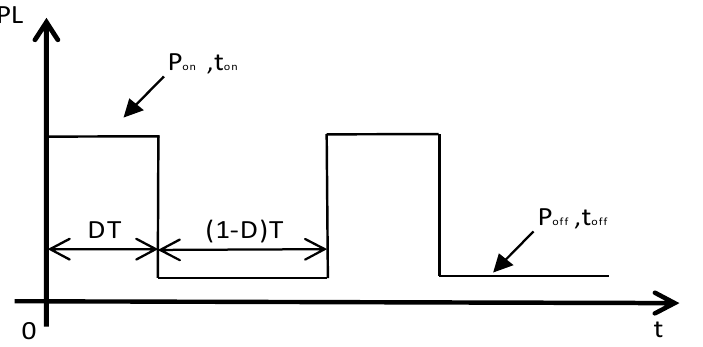
Figure 9. The power and bus voltage characteristics of PPL under different pulse periods.